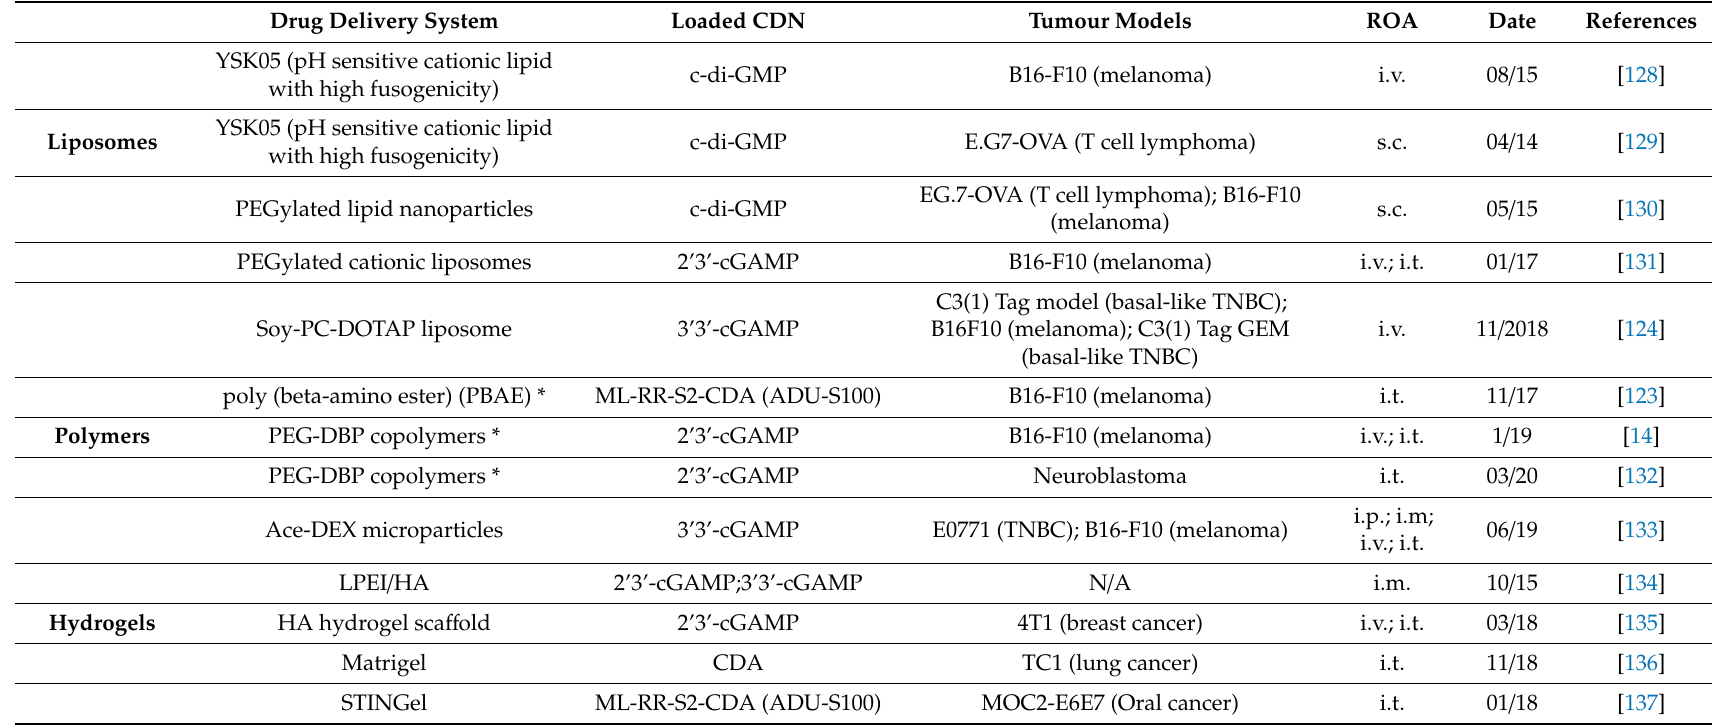
Table 3. STING agonist drug delivery systems for cancer